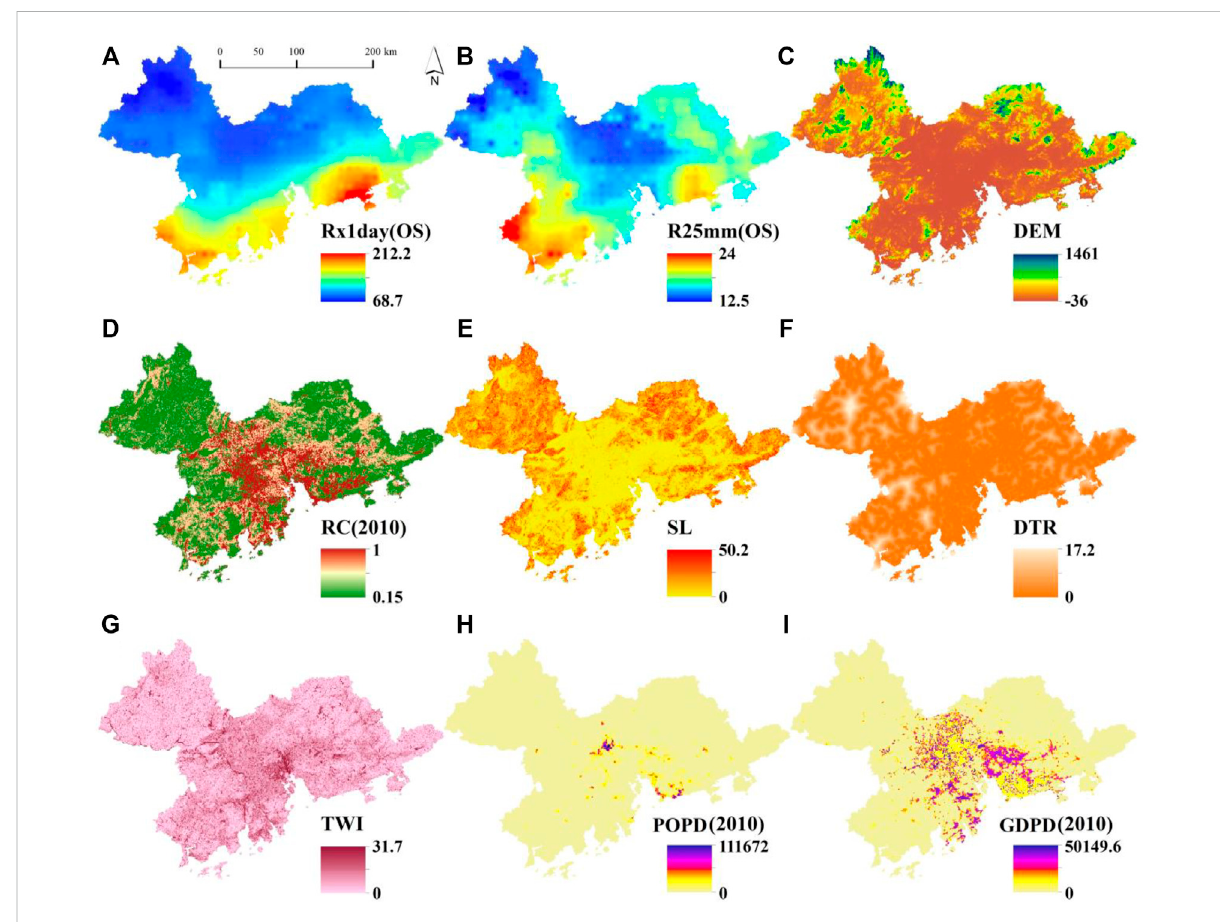
FIGURE 3 Spatialdistributionofdifferentindicesin2010overthePRD.Note: (A) Rx1dayinOS, (B) R25 mminOS, (C) DEM, (D) RCin2010, (E) SL, (F) DTR, (G) TWI, (H) POPD in 2010, and (I) GDPD in 2010.